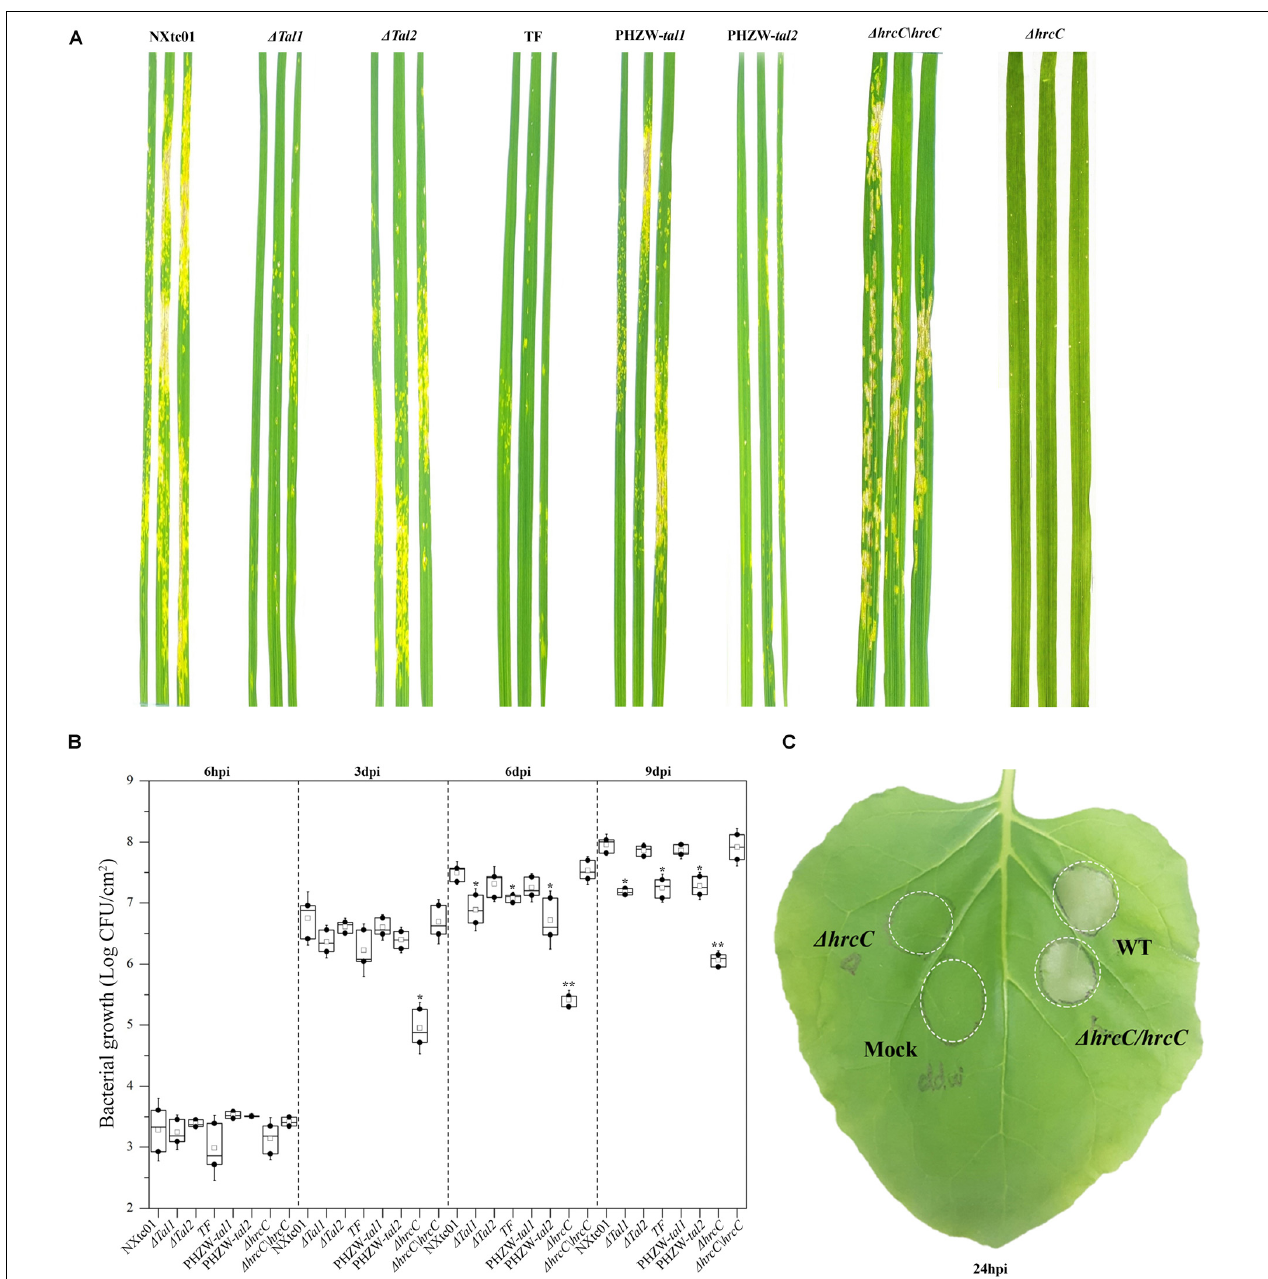
FIGURE 5 | Aggressiveness and bacterial growth of wild type Xtc NXtc01, deletion mutants and complemented strains. NXtc01 (WT), (cid:49) tal1 , (cid:49) tal2 , tal -free (TF), (cid:49) hrcC , PHZW- tal1 , PHZW- tal2, and (cid:49) hrcC/hrcC were sprayed-inoculated (OD 600 = 0.2) onto 3 weeks old wheat plants. (A) Symptoms were compared and photographed at 11 dpi. (B) Bacterial populations were quantified at 6 hpi and 3, 6, and 9 dpi. The box plot displays replicates ( n = 3) and mean value (middle box); error bars show mean ± SD. ∗ p < 0.05, ∗∗ p < 0.01 (Student’s t -test); indicates a significant difference compared to WT and (cid:49) hrcC/hrcC . (C) The inocula (OD 600 = 0.2) of WT, (cid:49) hrcC, (cid:49) hrcC/hrcC, and mock (ddw) were infiltrated into three to four leaves of 20 days old N. benthamiana plants using a needless syringe, and infiltrated areas were marked. Symptoms were observed and compared at 24 hpi. (A–C) Experiments were repeated at least three times with similar results. WT, Xtc NXtc01 (wild-type); (cid:49) tal1 , NXtc01 tal1 deletion mutant; (cid:49) tal2 , NXtc01 tal2 deletion mutant; TF, NXtc01 tal -free mutant; (cid:49) hrcC, NXtc01 hrcC deletion mutant; PHZW- tal1, NXtc01 TF with tal1 in trans ; PHZW- tal2, NXtc01 TF with tal2 in trans; (cid:49) hrcC/hrcC, NXtc01 (cid:49) hrcC containing hrcC in trans .